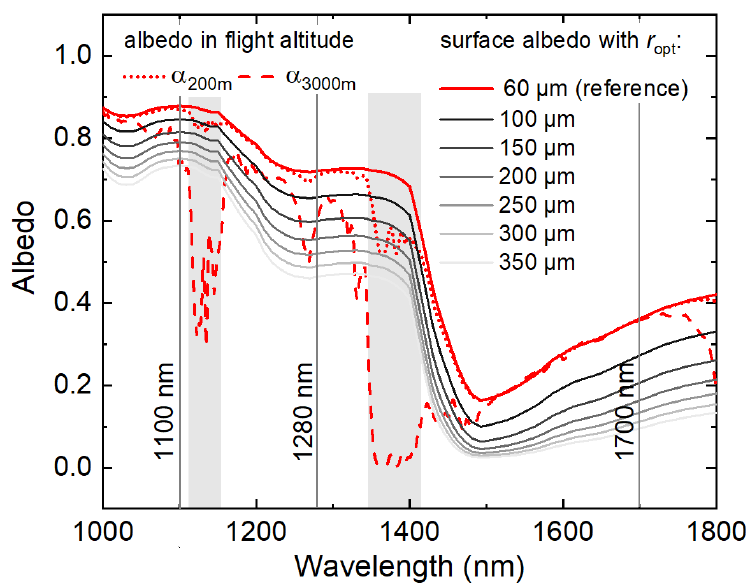
Figure 4. Spectral albedo derived from simulated upward and downward irradiance spectra at different altitudes (200 m, 3000 m) over the surface (red dotted and red dashed line). The default surface albedo (thick solid red line) represents the input surface albedo with a r opt = 60 µm (derived from TARTES simulations). The other solid lines are simulated albedo spectra for r opt ranging between 100 µm and 350 µm. The shaded areas mark the absorption bands of water